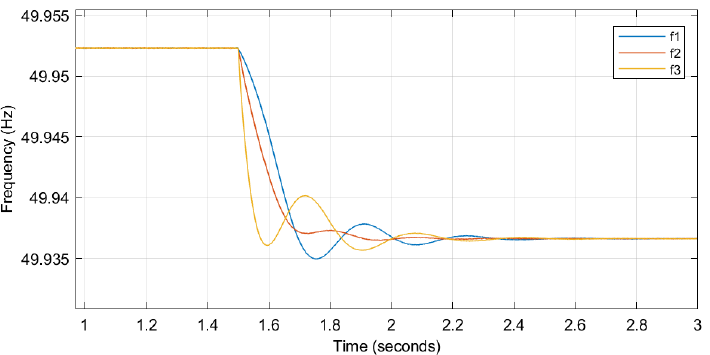
Figure 16. Frequency output of the droop controller with typical virtual impedance.